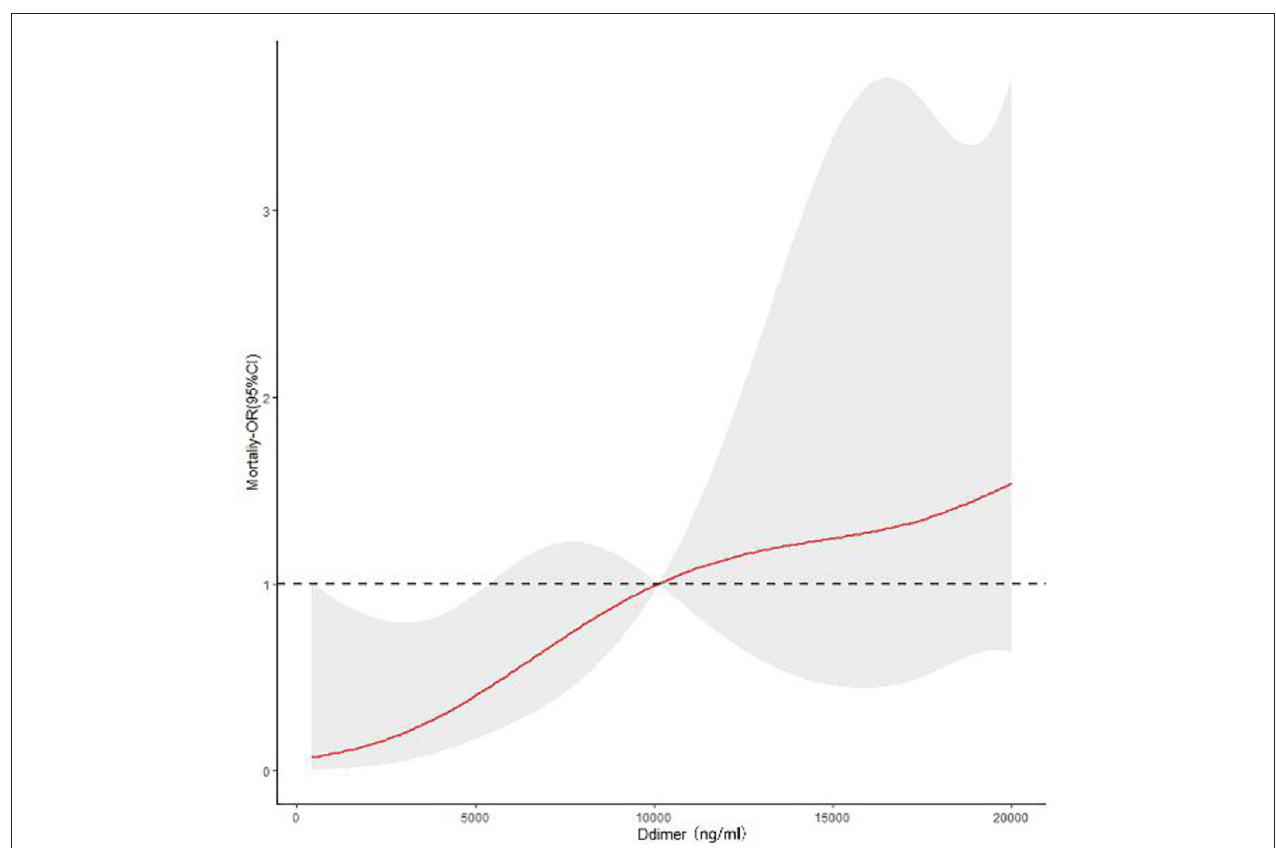
FIGURE 2 | Continuous odds ratio across D-dimer levels for mortality according to restricted cubic spline.